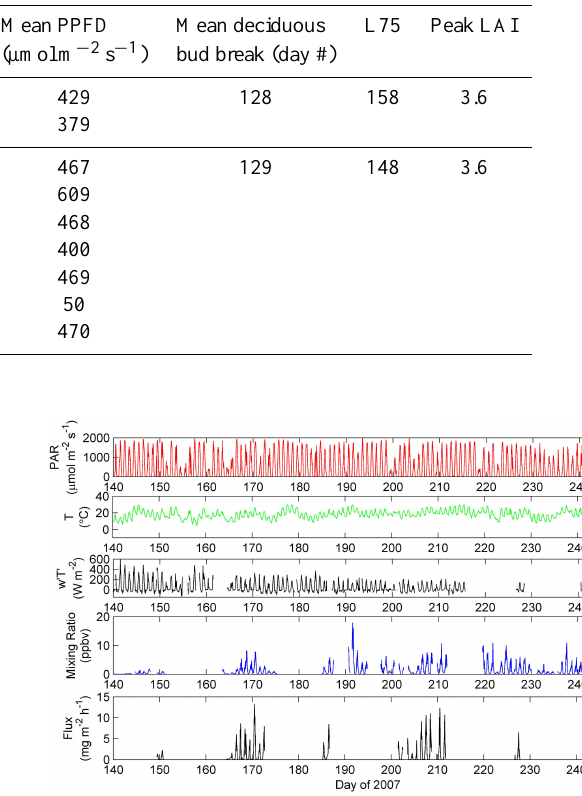
Table 2. Dates of reported observations during the 2005 and 2007 measurement seasons. Mean temperature, PPFD, the average day of deciduous bud break, the day by which 50% of the leaves in the canopy reached 75% of their mature size (L75), and the peak LAI for each year are also given.